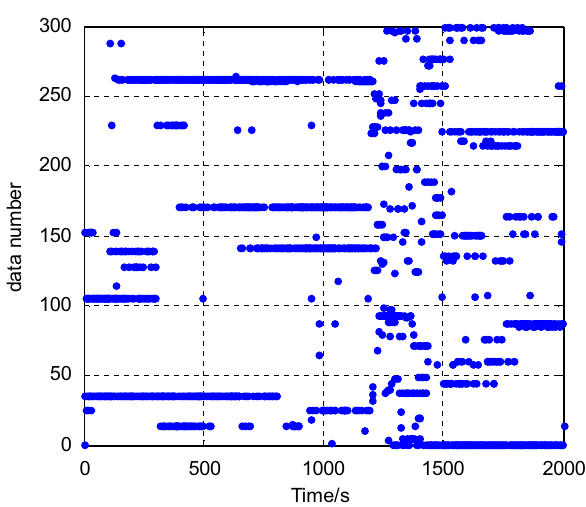
Figure 6: Identi fi cation results of trajectory matching sequence number based on fuzzy closeness.